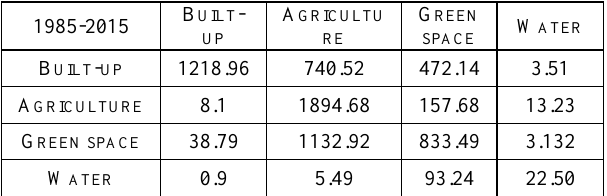
Table 6. The average surface temperature of various land